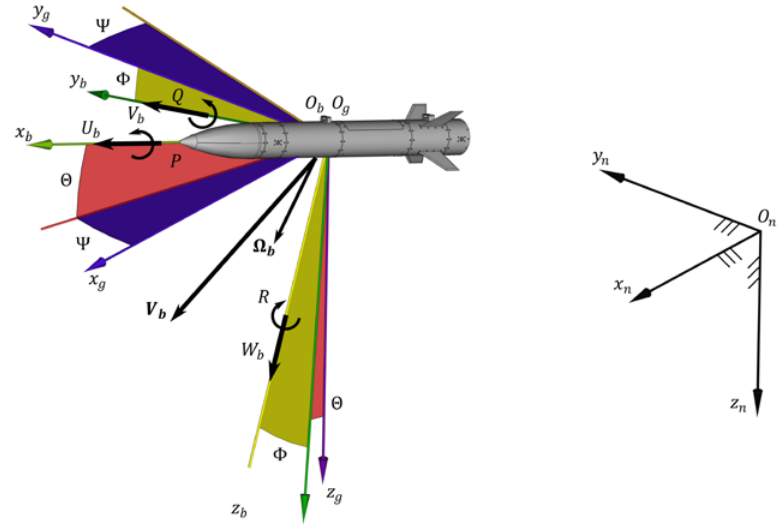
Figure 5. Coordinate systems used in the model.